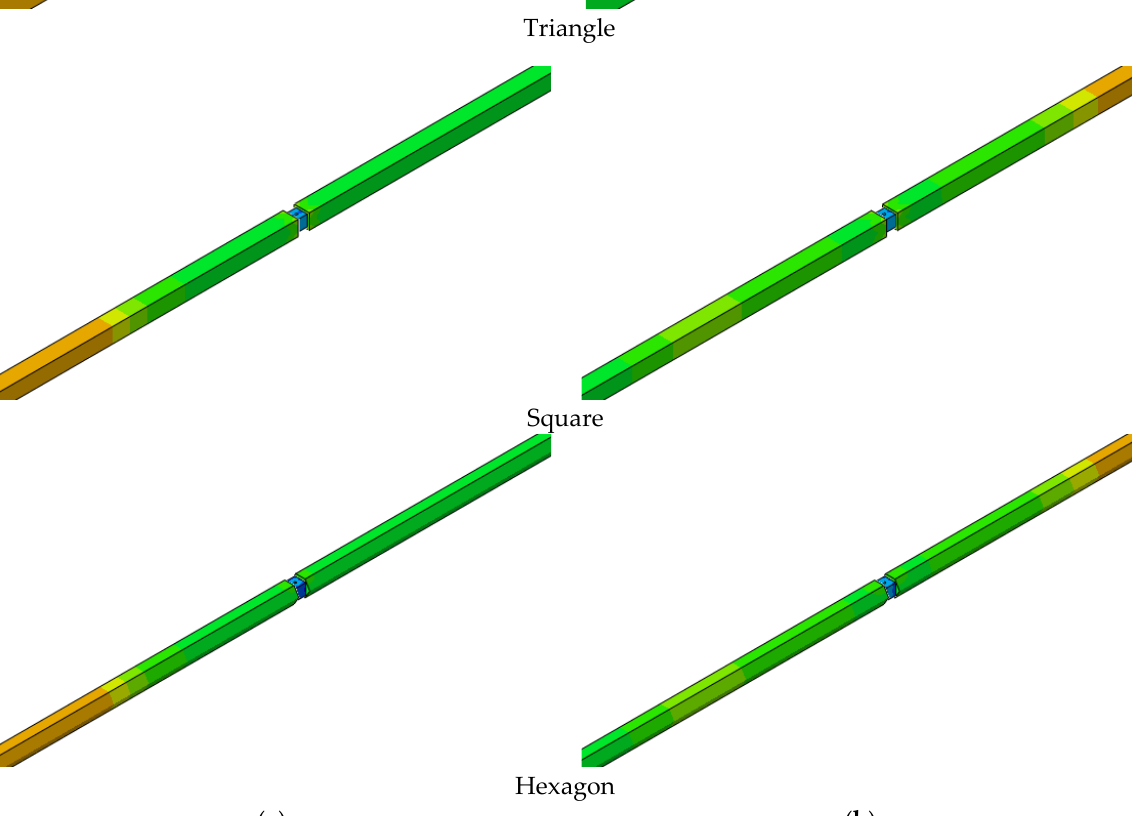
Figure 8. State of S33 stresses at two increments of time. ( a ) t = 0.6 ms and ( b ) t = 0.7 ms.